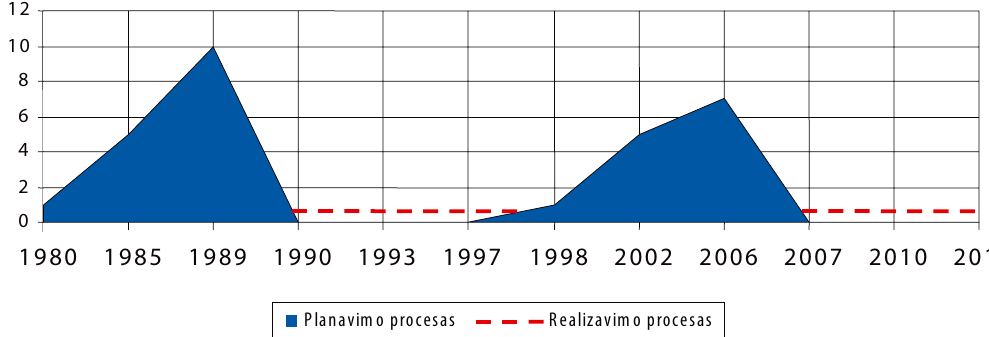
Fig. 1. Scale of planning and implementing fast transportation system in